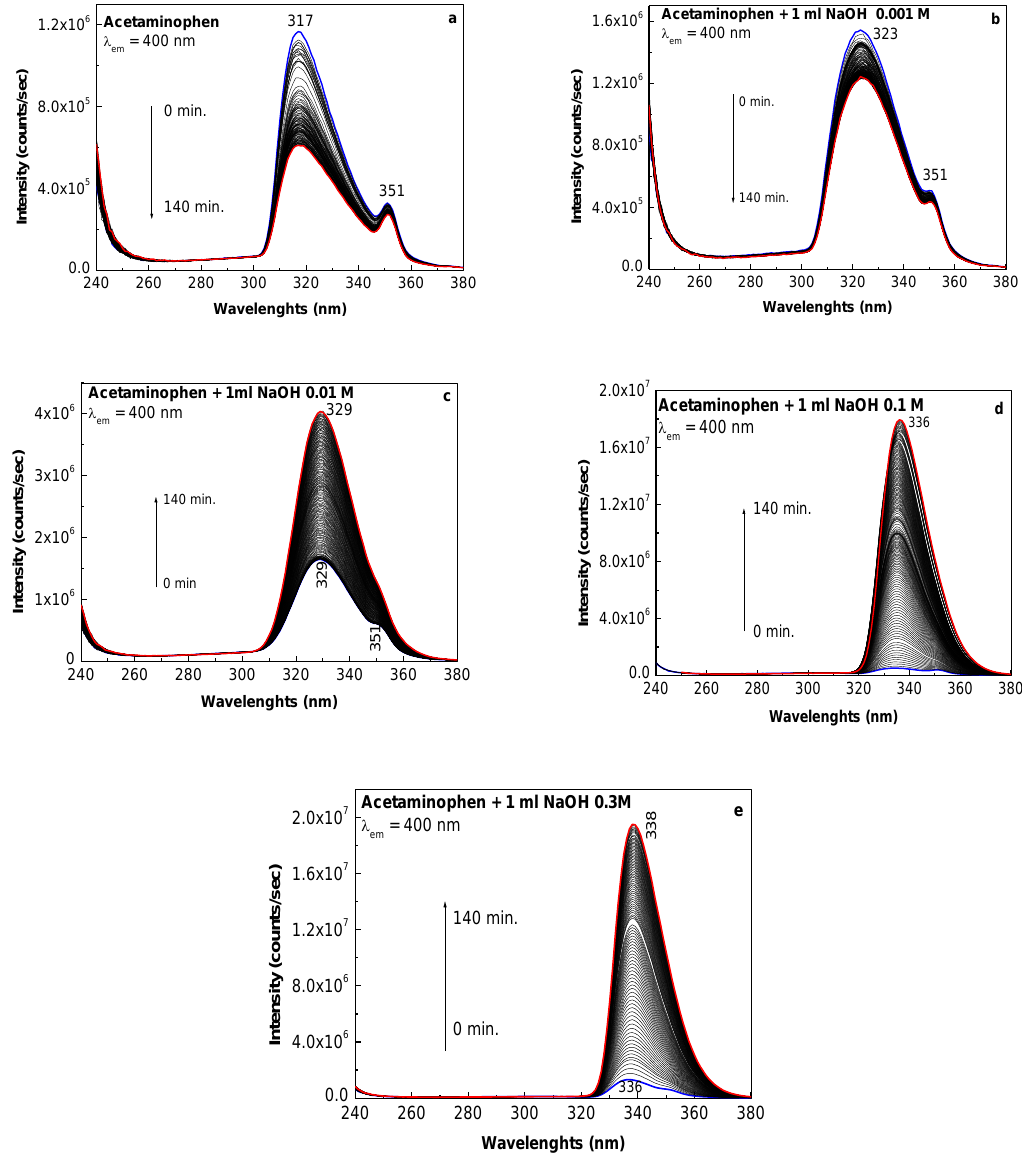
Figure 1. The photoluminescence excitation (PLE) spectra of the aqueous solution of acetaminophen (AC) before ( a ) and after the interaction with the aqueous solution of NaOH 10 − 3 M ( b ), 10 − 2 M ( c ), 10 − 1 M ( d ) and 3 x 10 − 1 M ( e ). All PLE spectra were recorded at the emission wavelength of 400 nm. Blue and red curves correspond to the first and last spectrum, respectively, of the samples exposed to UV light for 0 and 140 min. Black curves correspond to the intermediate spectra of above samples, each PLE spectrum being collected at 84 s, respectively.